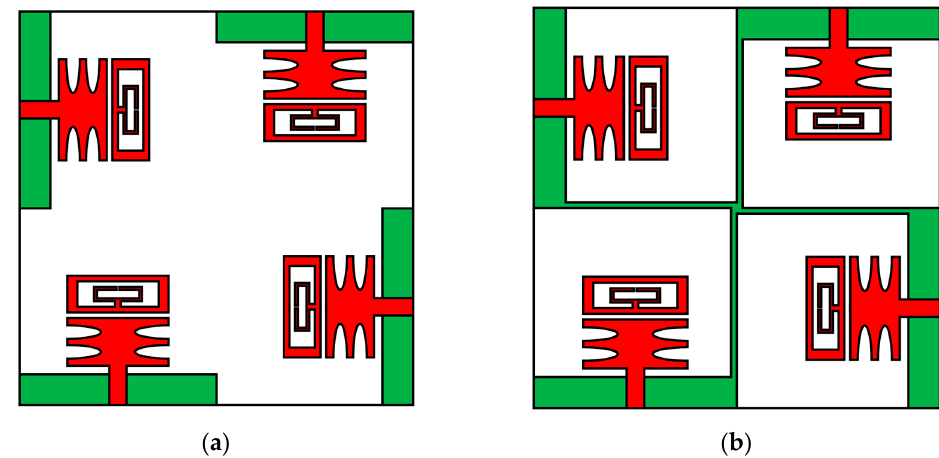
Figure 4. Designing of the MIMO radiator: ( a ) Antenna-7; ( b ) Antenna-8.